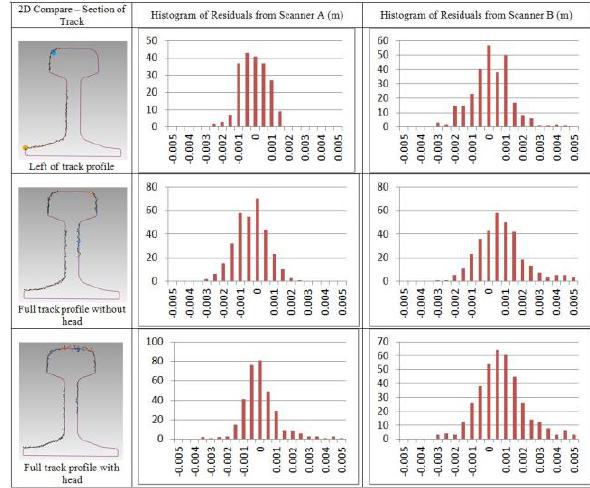
Table 2 - 2D Comparison Results from Scanner A and